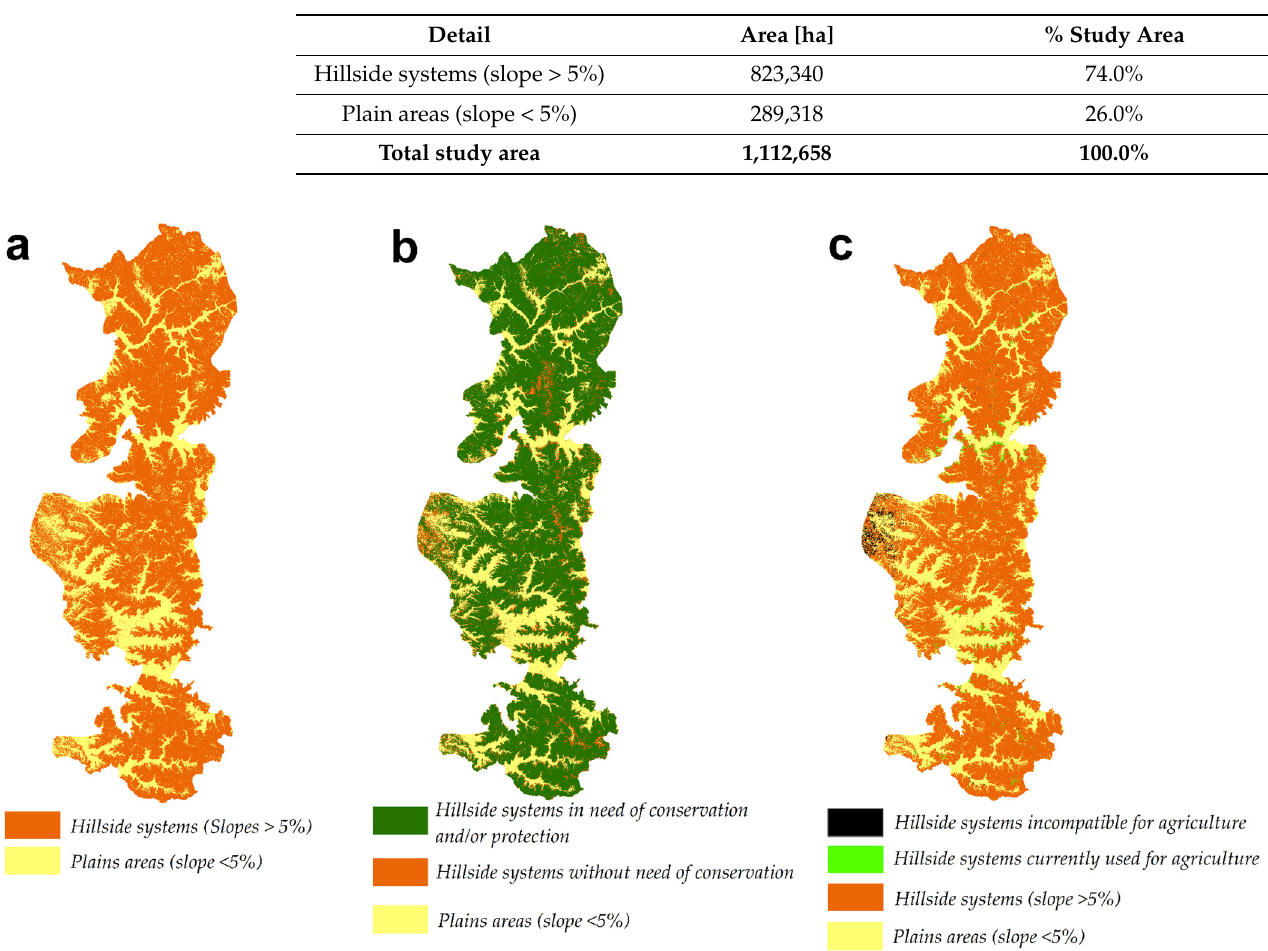
Table 2. Description of study area (Figure 4a).